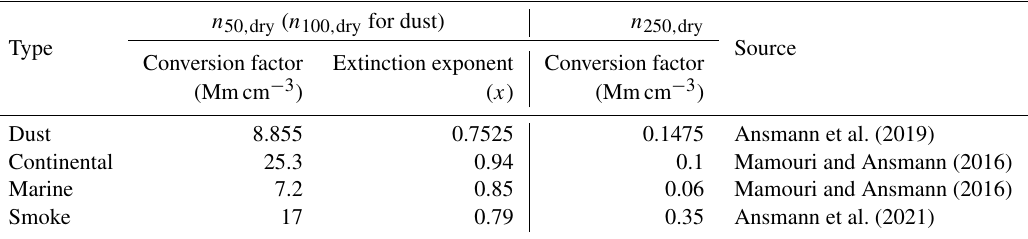
Table 2. POLIPHON conversion factors and extinction exponents for different aerosol types to be used in Eq. (1) for estimating the aerosol number concentrations from the extinction coefficient. The value of the extinction exponent ( x ) for n 250 , dry is 1 for all the aerosol types.